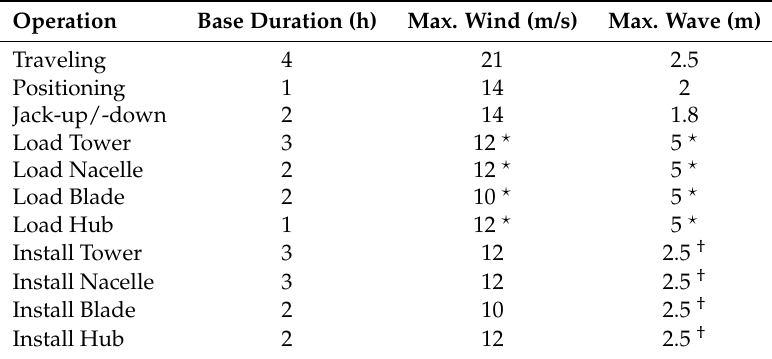
Table 1. Duration of basic